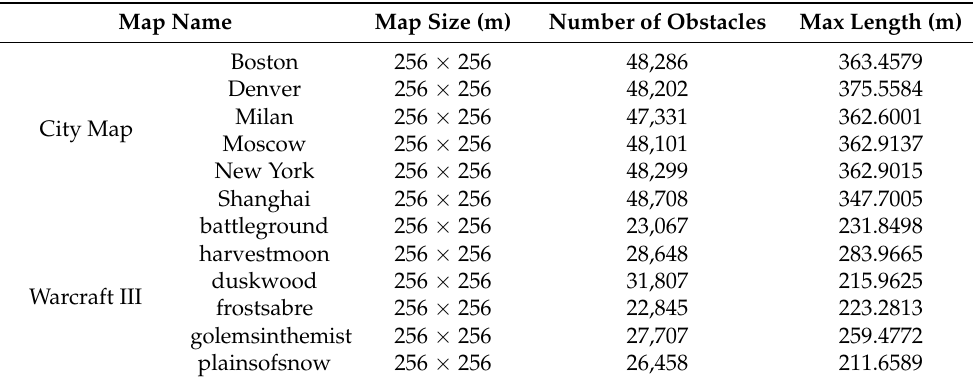
Table 10. Map information selected for the